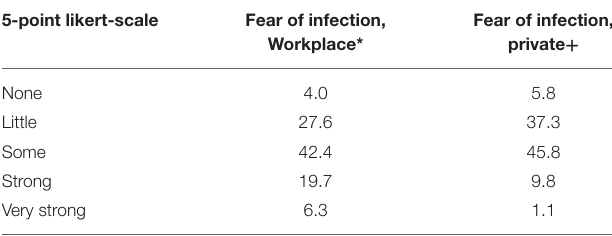
TABLE 1 | Composition of the sample of HCWs at Hannover medical school. Items, selected